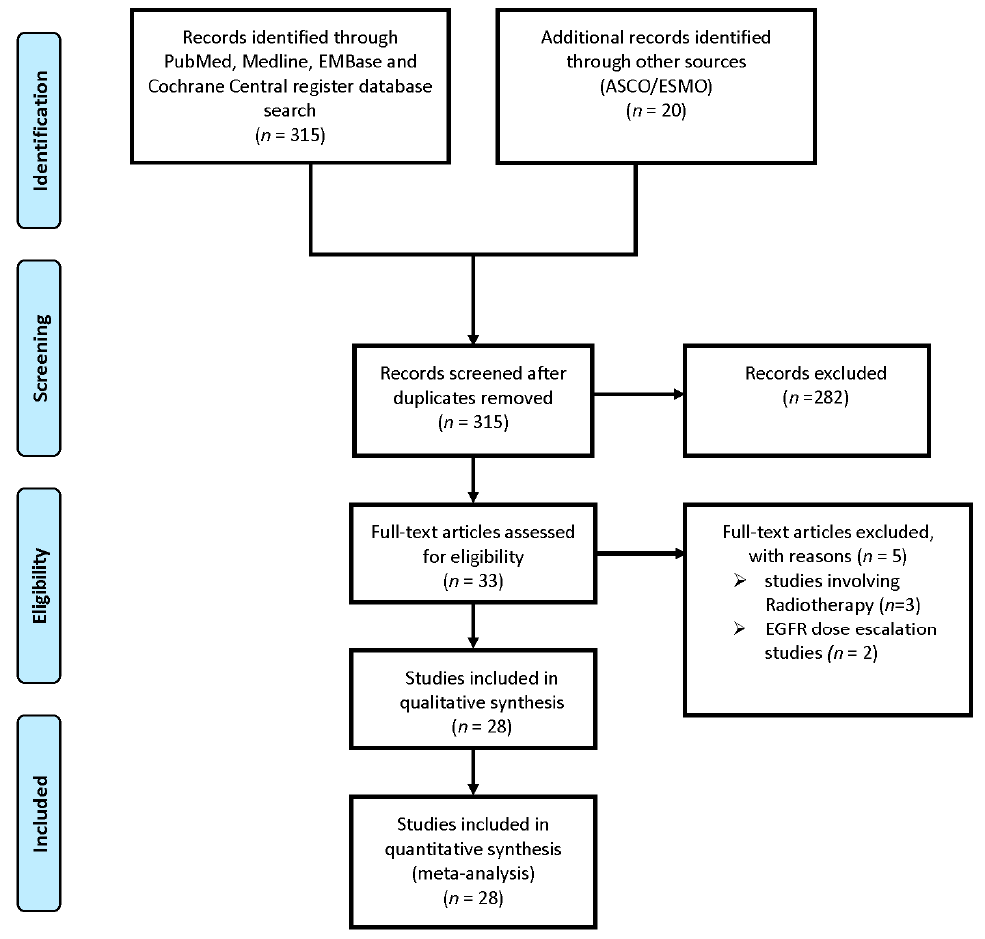
Figure 1. Flow chart outlining search strategy and details on final included and excluded studies in the meta-analysis. n : number; ASCO: American Society of Clinical Oncology; ESMO: European Society of Medical Oncology; EGFR: epidermal growth factor receptor.